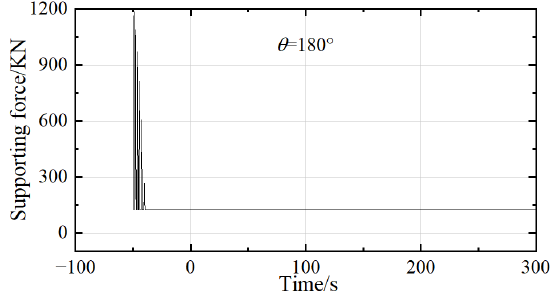
Figure 10. The supporting force of the offloading vessel under different wave directions.